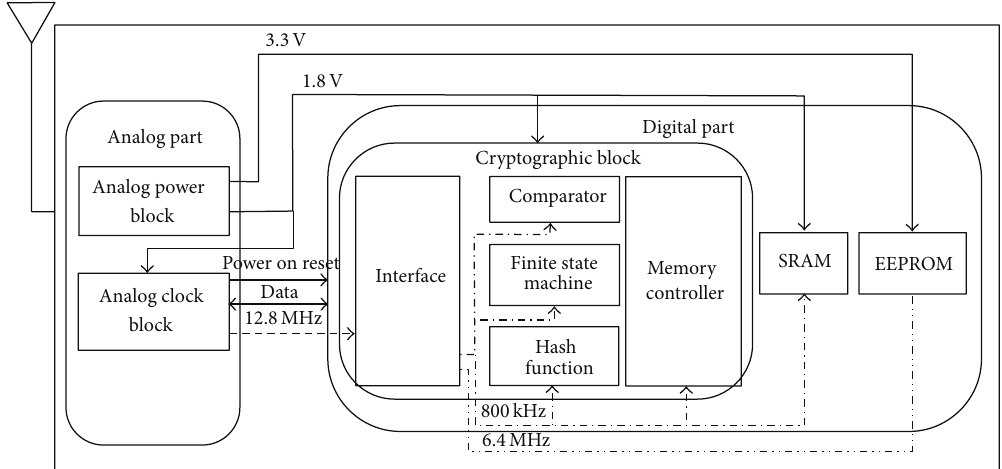
Figure 1: Block diagram of the single